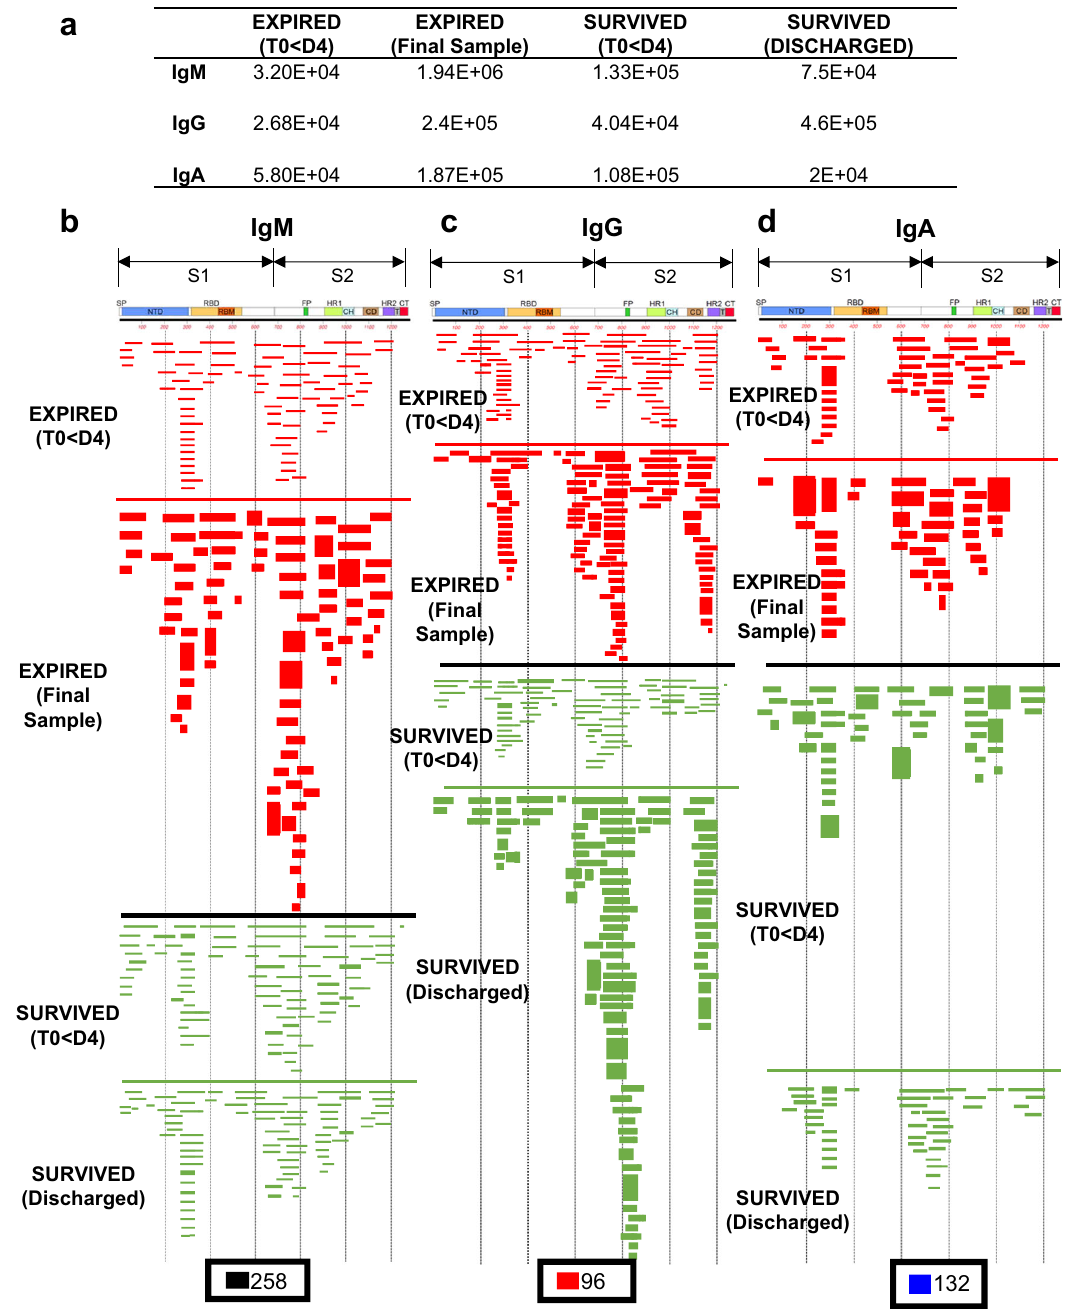
Fig. 3 IgM, IgG, and IgA antibody epitope repertoires elicited in expired vs. survived (non-ICU) hospitalized COVID-19 patients. Distribution of phage clones after af fi nity selection on plasma samples collected at early vs. late time points from hospitalized patients. a Number of IgM, IgG, and IgA bound phage clones selected using SARS-CoV-2 spike GFPDL on pooled polyclonal samples from “ expired ” patients (E-18, E-34, and E-58), collected from